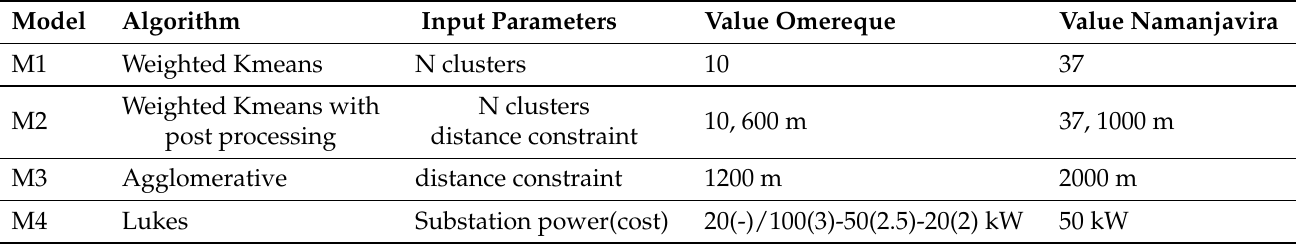
Table 2. Simulations